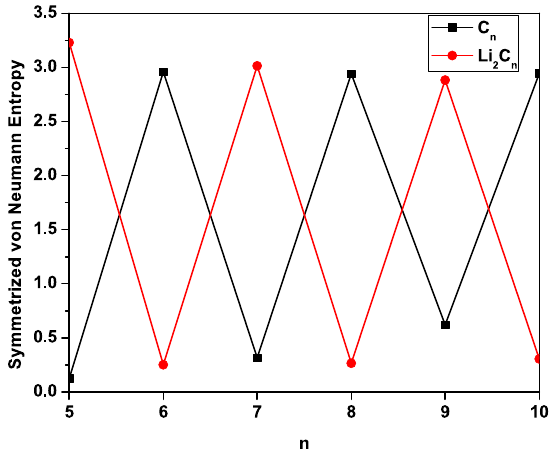
Figure 5. Symmetrized von Neumann entropy for the lowest singlet state of C n /Li 2 C n as a function of the chain length, calculated using TAO-BLYP-D.